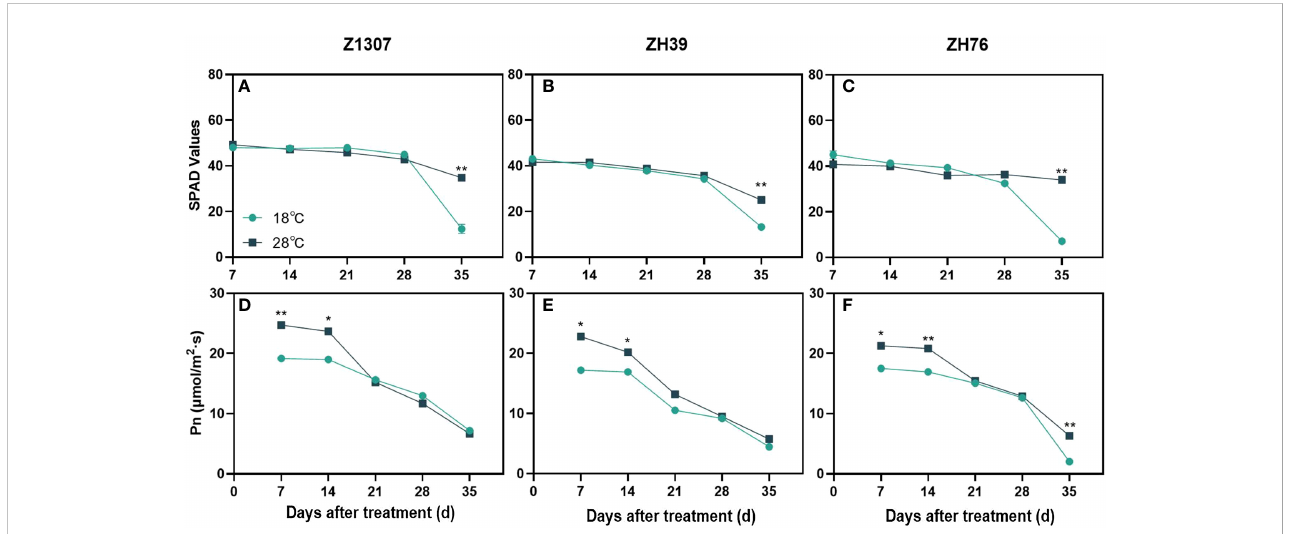
FIGURE 4 Effects of high night temperature on SPAD value and net photosynthetic rate of leaves under different night temperatures. The light blue/ black blue line indicates the 18 ℃ /28 ℃ treatment. The broken lines respect the dynamic changes of the SPAD value (A-C) and photosynthetic rate (D-F) of soybean leaves with the days of different high night temperature treatments for the three varieties of Z1307, ZH39 and ZH76. Values shown are means ± SE from three biological replicates. (*, P < 0.05; **, P < 0.01).